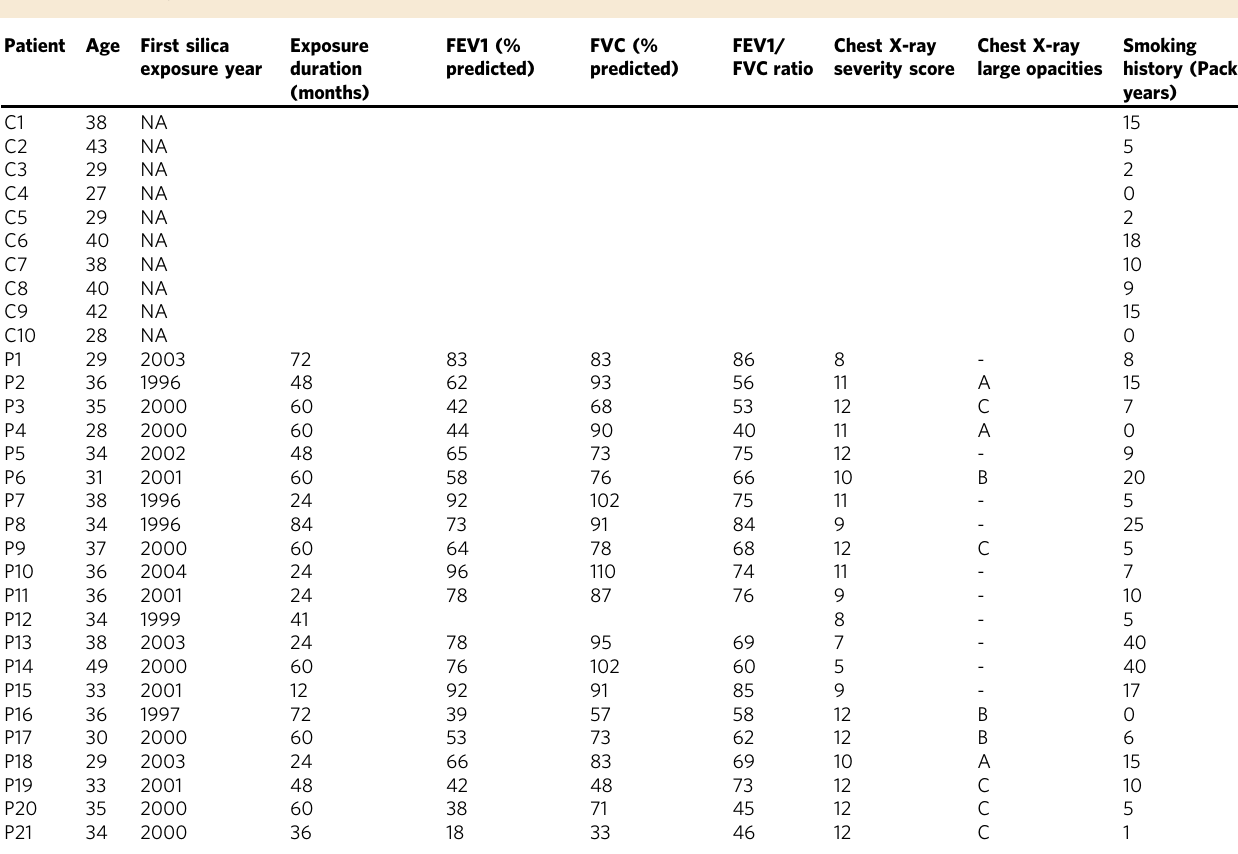
Table 1 Silicosis patient clinical characteristics Patient Age First silica exposure